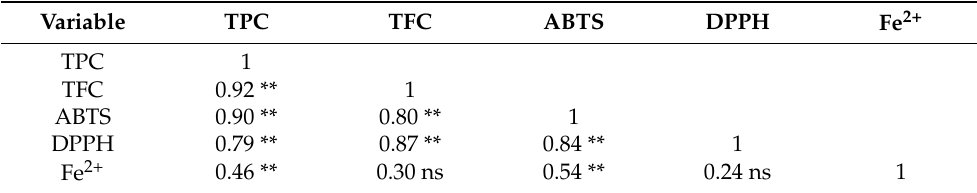
Table 6. Pearson’s correlation analysis between